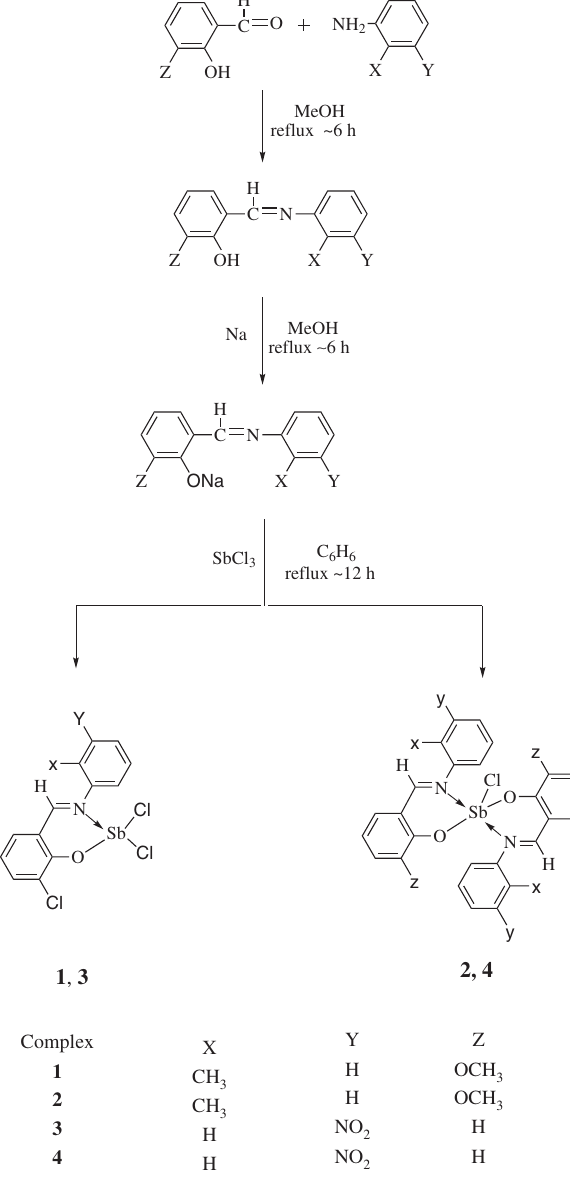
Scheme 1: General method for the preparation of Schiff bases and antimony(III)